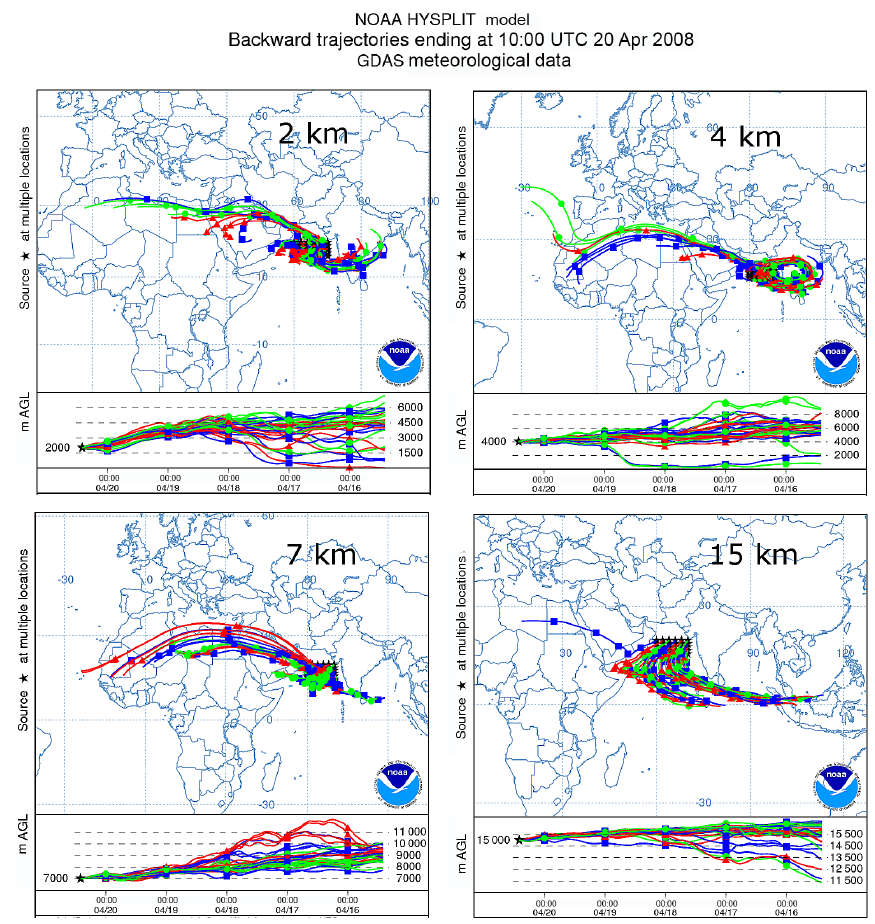
Figure 6. HYSPLIT trajectory 120h backward model results for air masses at AS with source location at 2, 4, 7 and 15km.